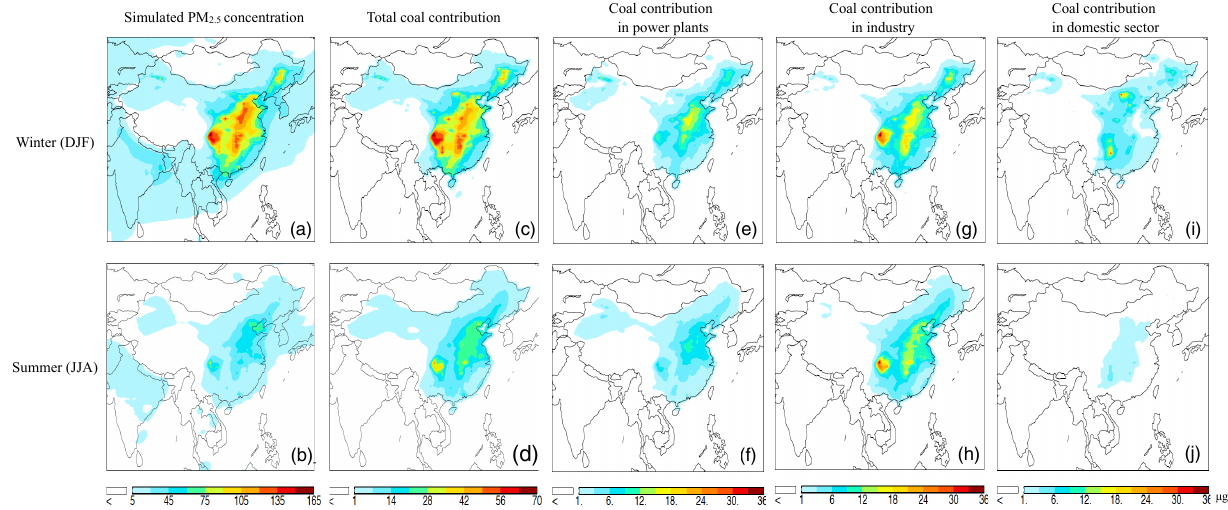
Figure 8. Seasonal contributions from coal burning in winter and